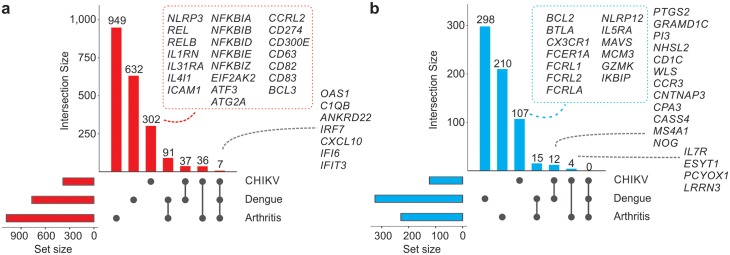
Comparing CHIKV signatures with those from rheumatoid arthritis and Dengue infection.(a) Genes up-regulated in patients infected with either CHIKV or Dengue or rheumatoid arthritis (RA) patients compared to their respective controls. The size of the bar represents the quantity of up-regulated genes detected in one or more groups (indicated as a gray circle in the graph below). Representative up-regulated genes are displayed. The gray circles below the bars indicate the groups that share the same up-regulated genes. (b) The same approach as in (a) but for the down-regulated genes.